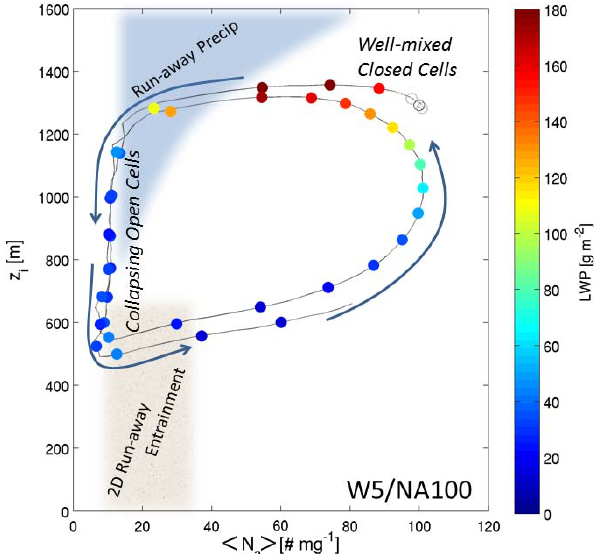
Fig. 11. Phase plane plot like Fig. 10, but for W6.5 cases initial- ized along a two-dimensional grid of MBL aerosol concentration and inversion height. Different symbols indicate the initial aerosol concentration. Blue dashed line shows the boundary for regime tran- sition under runaway precipitation. The equilibrium is marked by an